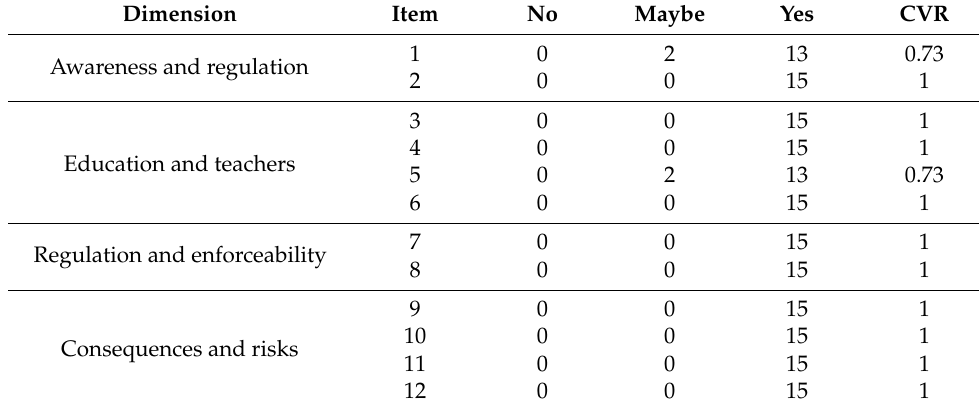
Table 3. Content validity reason (CVR) of items.